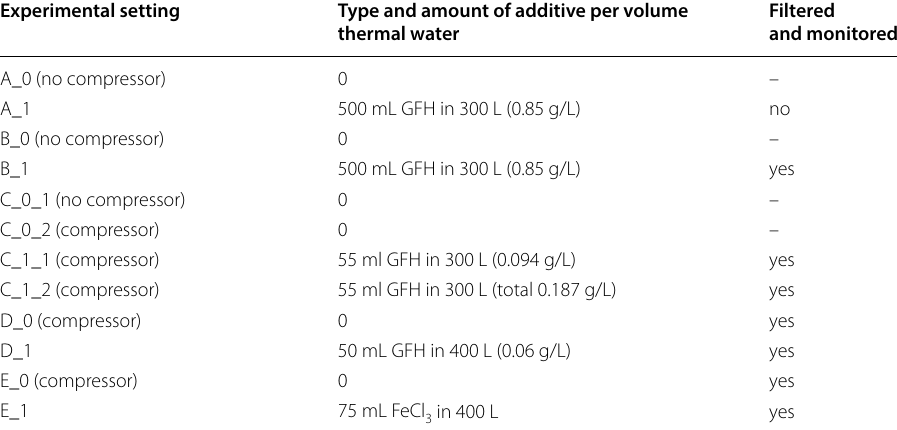
Table 1 Experimental setting and amount of used additives (GFH or 40% FeCl Experimental setting Type and amount of additive per volume